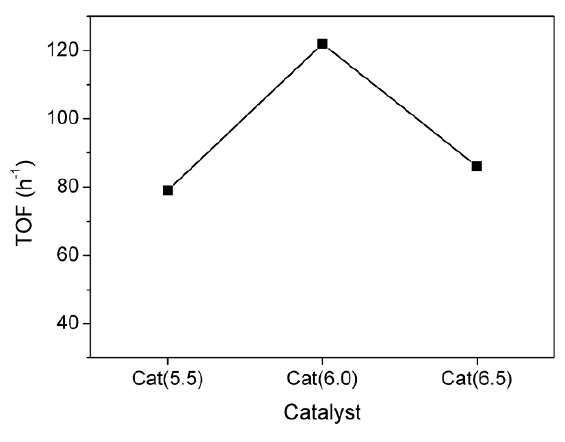
Figure 5. TOF of the supported gold catalysts for benzyl alcohol oxidation at t = 3